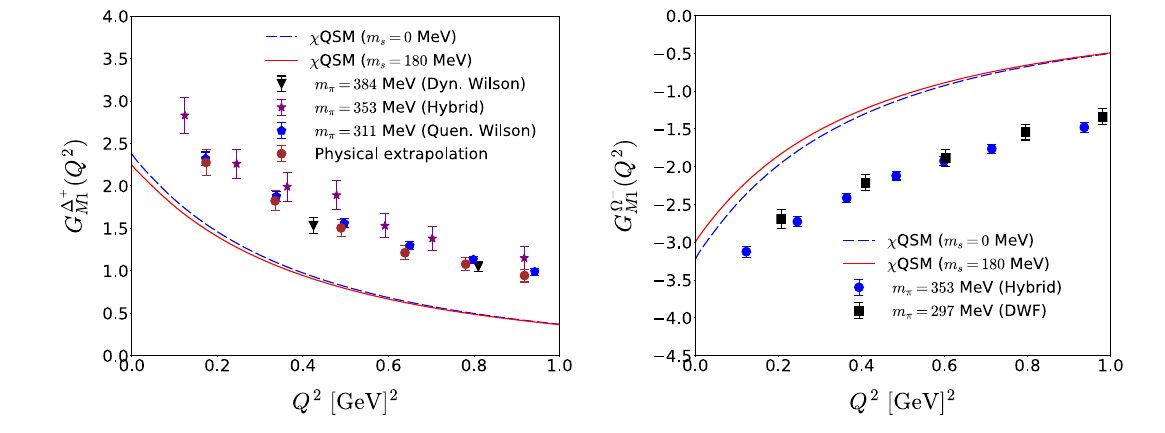
Fig. 9 Effects of the explicit flavor SU(3) symmetry breaking on the magnetic dipole form factors of the (cid:2) + isobar and (cid:5) − in the left and right panels, respectively. The dashed curves depict the E0 form fac- tors without the effects of the explicit flavor SU(3) symmetry breaking,